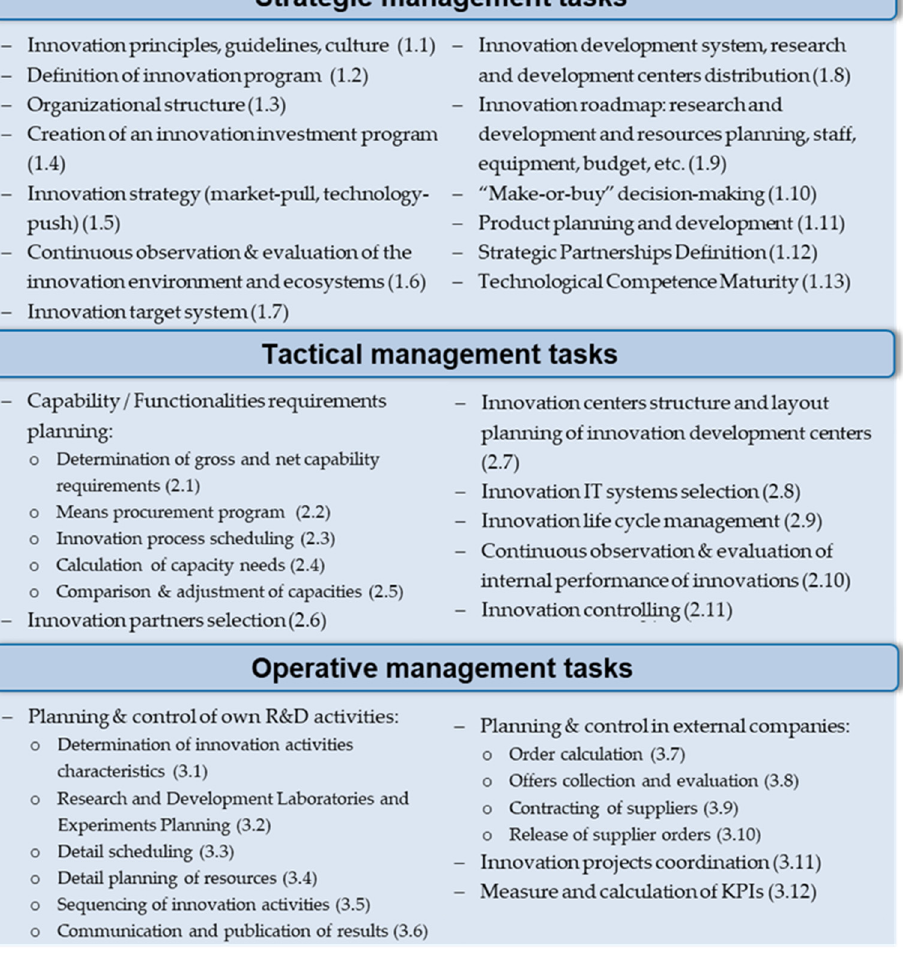
Figure 1. Innovation management tasks according to planning horizons (own elaboration based on [44]).